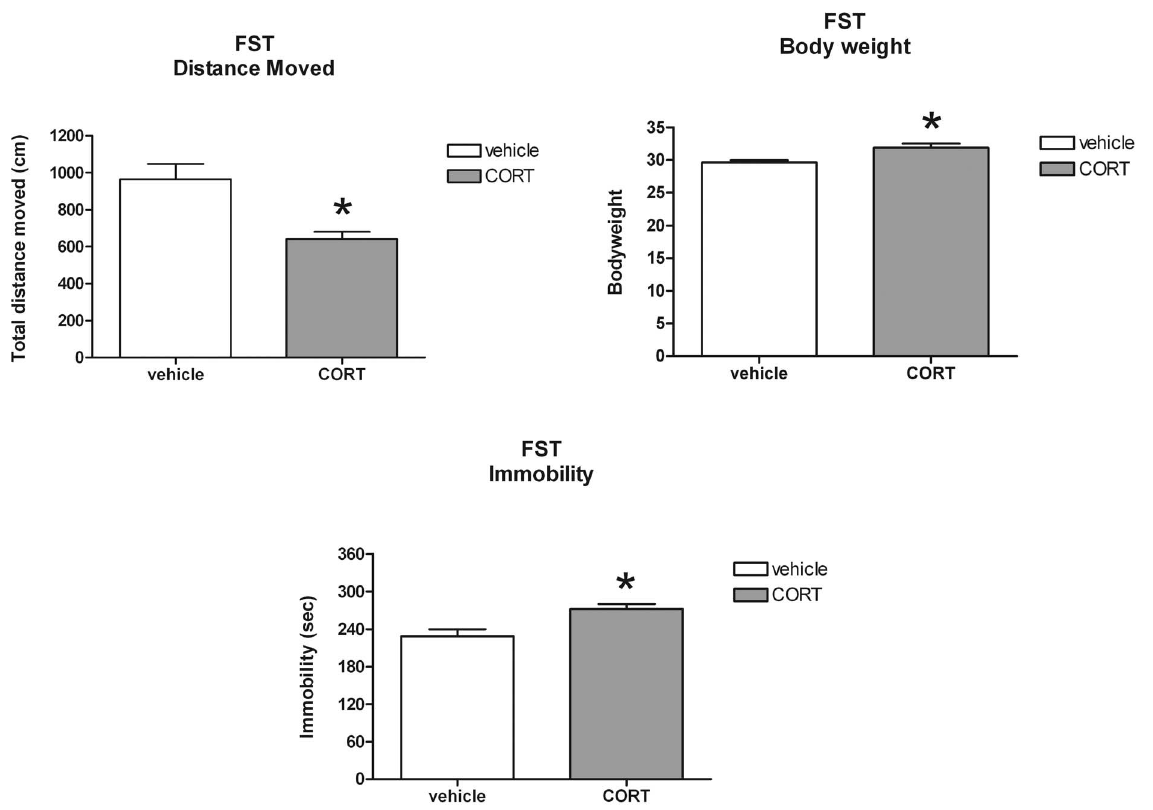
Figure 8. Effect of corticosterone (CORT) administration via the drinking water (mean + S.E.M.) upon total distance moved, body weight at time of testing and total immobility time in the forced swim test (FST). *Significant difference between CORT and vehicle treatment ( P , 0.01).